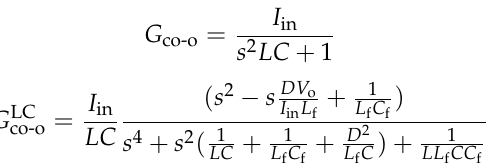
Figure 13. Current-fed buck converter with an input CL filter.